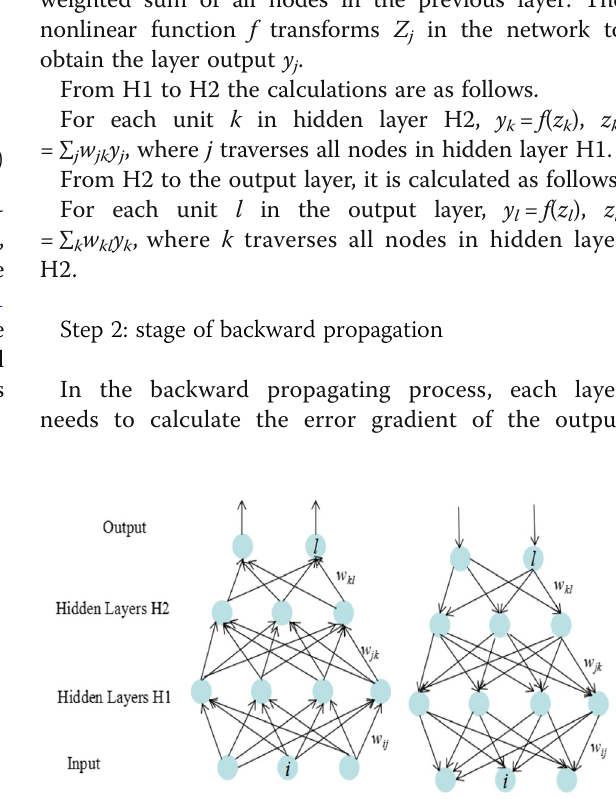
Fig. 2 Calculation process of forward propagation (left) and backward propagation (right). Forward propagetion calculates from the input unit to the output unit, backward propagation does the opposite and corrects the intermediate